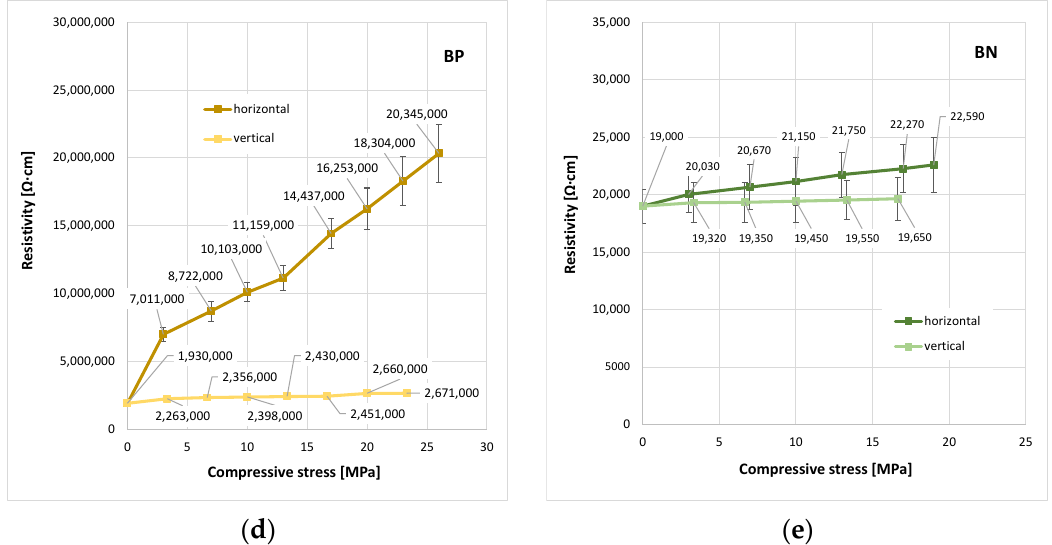
Figure 8. Dependence of resistivity on compressive stress for mixtures ( a ) REF; ( b ) AP; ( c ) AN; ( d ) BP; ( e ) BN.